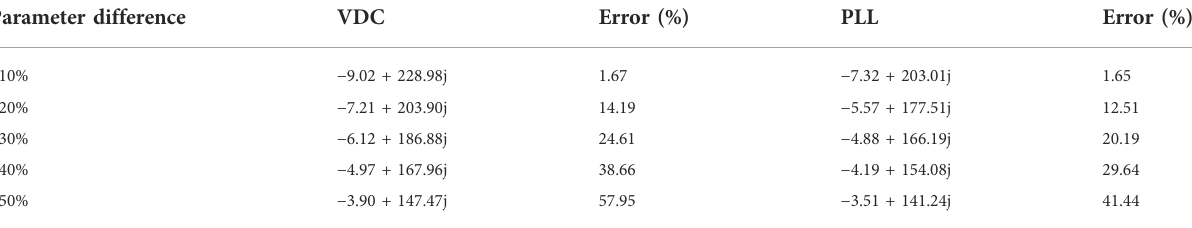
(VDC mode and PLL mode using the aggregated representation, respectively, are − 9.37 + 232.78j and − 6.94 + 199.69j).